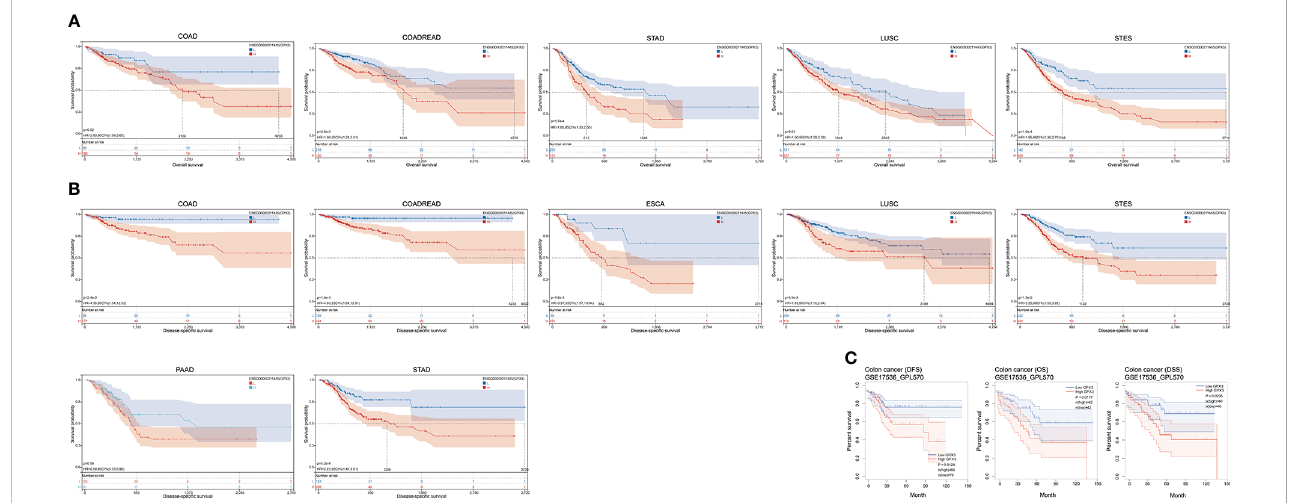
FIGURE 3 The correlations between GPX3 expression and the prognosis of human cancers. (A) GPX3 was negatively associated with OS of COAD, READ, LUSC, STAD, and STES. (B) GPX3 was negatively associated with DSS of COAD, READ, ESCA, LUSC, PAAD, STAD, and STES. (C) higher GPX3 expression was correlated with poor outcome of COAD patients in GEO